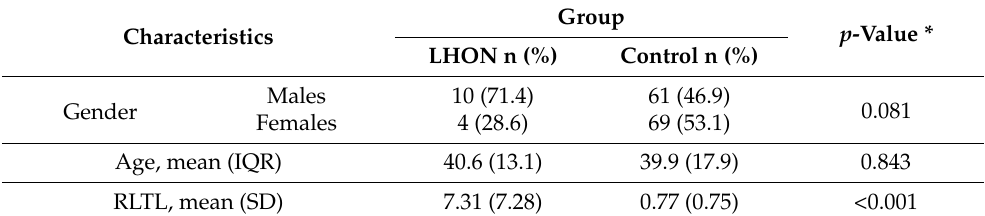
Table 1. Demographics.